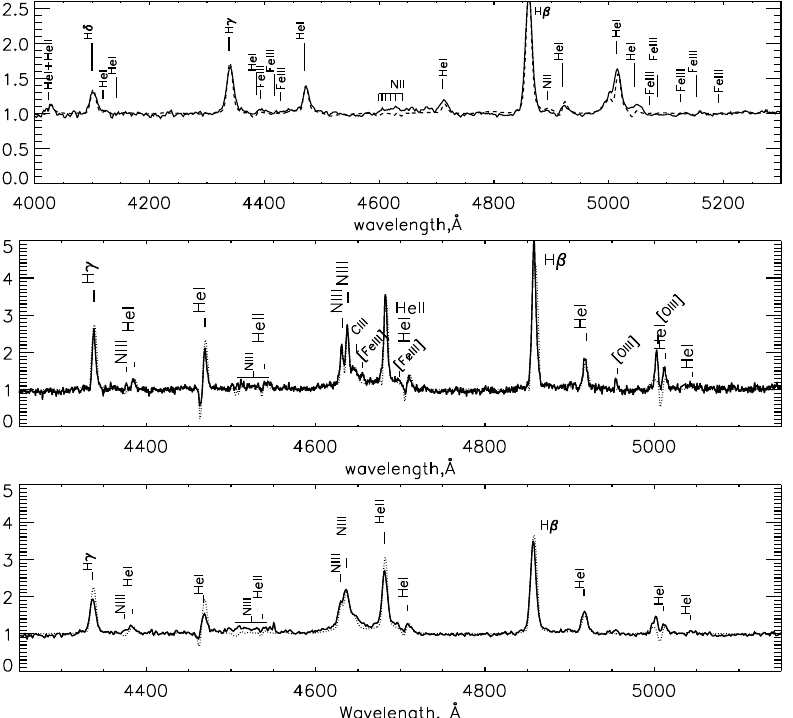
Fig. 1. The normalized optical spectrum (solid curve) compared to the best-fit cmf- gen models (dashed curve). Top panel: the spectrum obtained in February 2005 when V532 was at 17.27 mag in the V passband. Middle panel: the spectrum obtained in October 2007 ( V = 18.68 mag). Bottom panel: the spectrum obtained in August 2014 ( V = 18.7